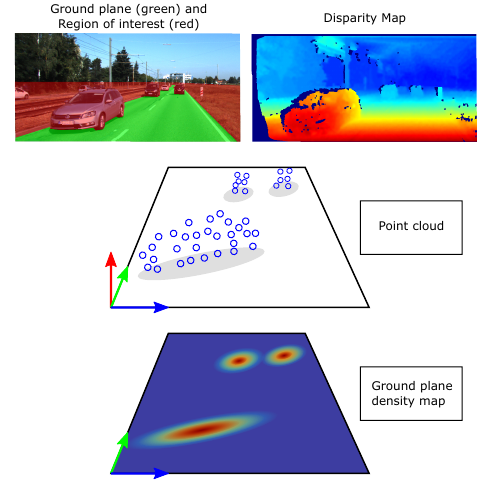
Figure 2. Detection of generic object